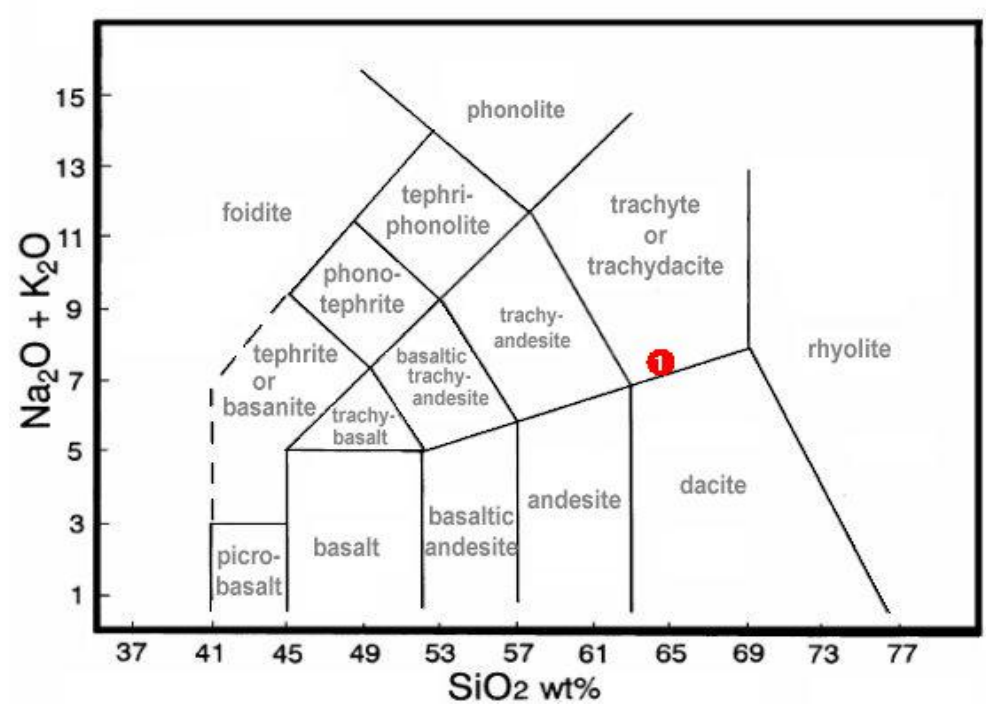
Figure 2. Chemical classification of Sille stone based on the total alkali–silica (TAS) diagram Figure 2: Chemical classification of Sille stone based on the total alkali–silica (TAS)